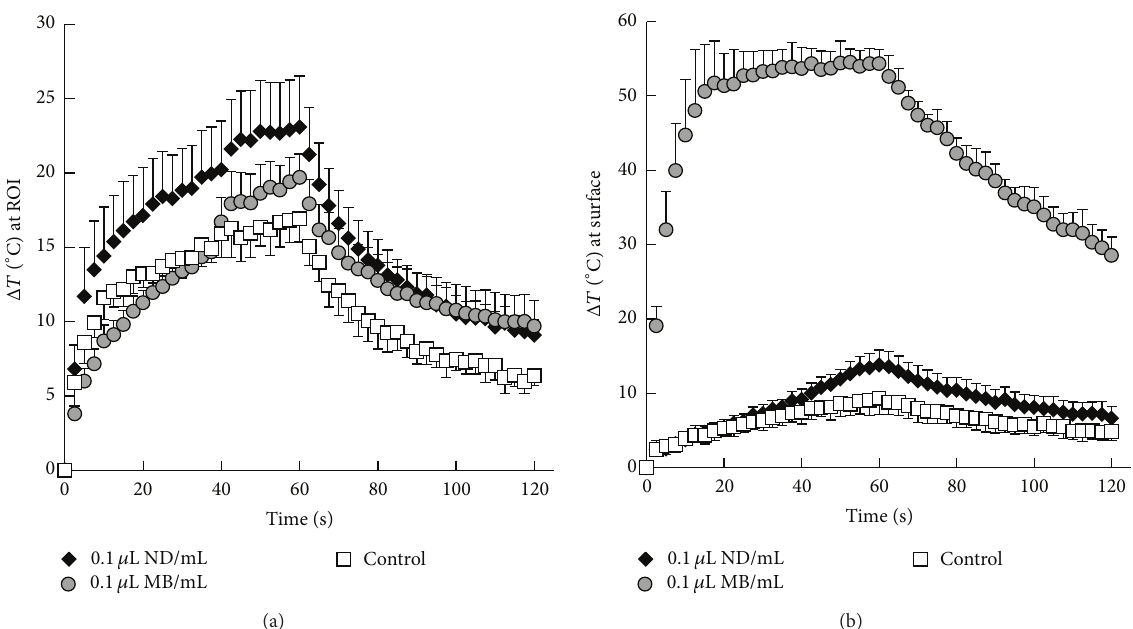
Figure 11: For each MR acquisition over time, the maximum change in temperature (a) at the focus (ROI) and (b) surface of the phantom was extracted from the corresponding horizontal slices from those locations. Time curves were averaged, and data are presented as the means ± s.d. ( 𝑛 ≥ 3). Phantoms contained 0.01 𝜇 L of nanodroplets or microbubbles per milliliter of phantom material or no agents (control). Reprinted with permission from Phillips et al. [80]. Copyright 2013, Acoustic Society of